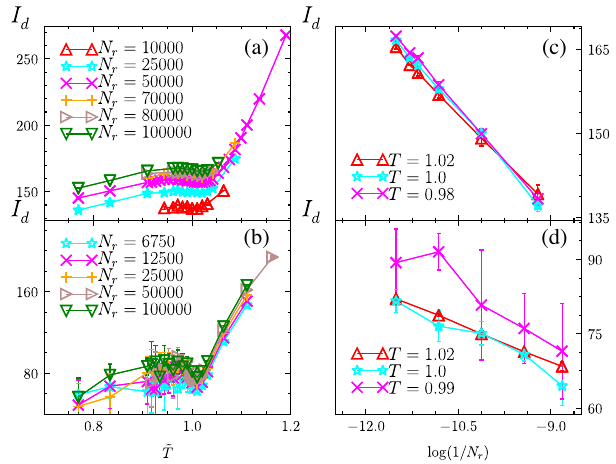
FIG. 13. Temperature dependence of the I d for different values of N r for the (a) 2D XY model and (b) three-state Potts model; in both cases, L ¼ 60 . For each point, we harvest approximately ten instances of the data set and average the resulting estimates for the I d . The error bars are the standard deviation of such results. The scaling of I d with N r for certain values of T for: (c) the 2D XY model, (d) the three-state Potts model.